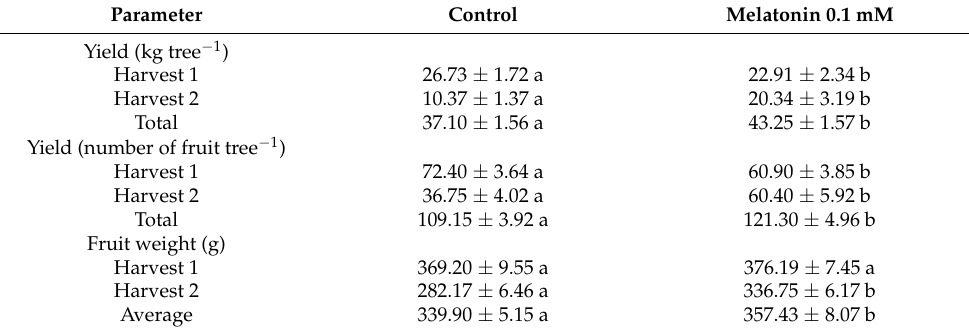
Data are the mean ± SE. For each parameter and harvest date, different letters within a row show significant differences at p < 0.05.